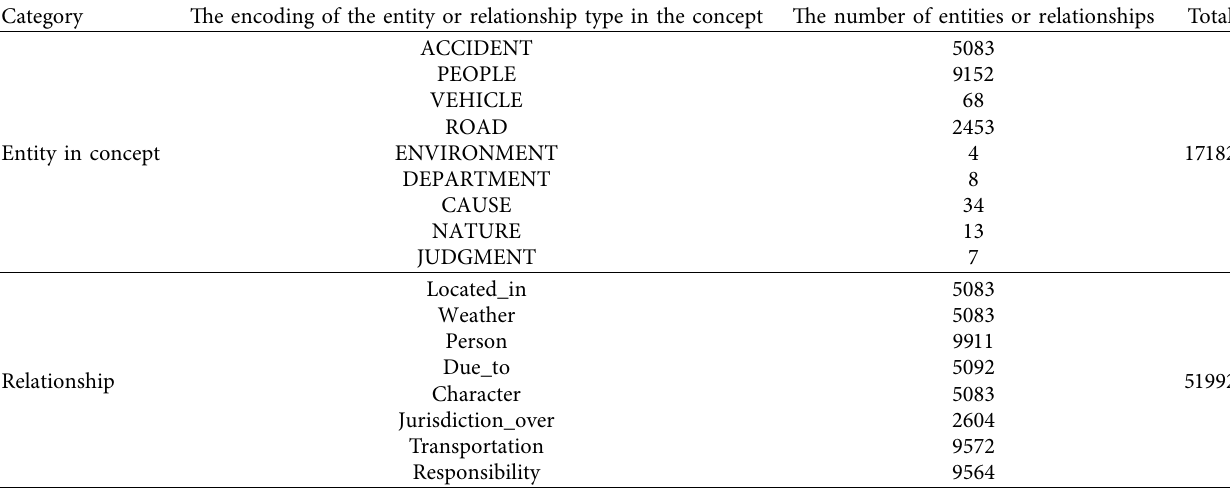
Table 3: Extraction results of different types of entities and relationships.